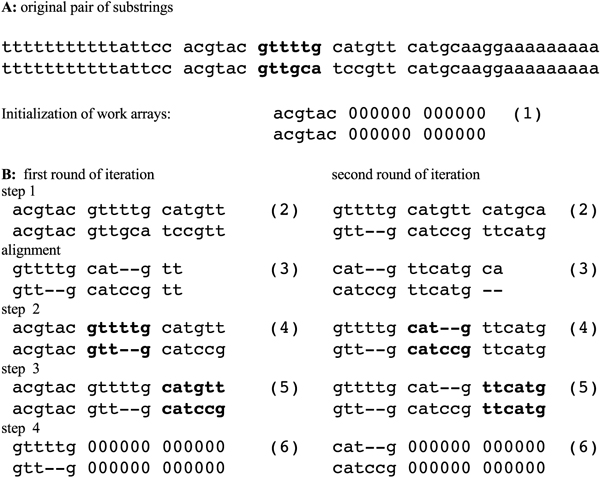
Match extension by window alignment for W = 6 and K = 2. Match extension by window alignment for window size W = 6 and maximum number of errors K = 2. A: We show the original pair of sub-sequences. Beginning from the left, the first window with 3 errors is printed in bold. Both neighbouring windows are separated by blanks. The work arrays (1) are initialized with the contents of the left hand side windows. B: We show the changes of the work arrays for the single steps of iterations described in Section Algorithm. Step 1: The central and right hand side blocks of (1) are overwritten by the next 12 original sequence characters yielding (2). An optimal alignment of these 12 sequence characters is given in (3). Step 2: The central blocks of (2) are overwritten by the first six characters of the alignment (3) and the right hand side blocks of (2) are overwritten by the next 6 original sequence characters yielding (4). Step 3: From the left to the right the first window of size 6 with 3 errors is printed in bold. Its starting position is T = 2W +1 and the existence of gaps in the central block requires step 4. Step 4: The central blocks of (5) are shifted to the start positions of the work arrays to set the initialization for the next round of iteration shown to the left of the first round. The third round of iteration ends in step 3 without gaps in the central and right hand side blocks of (5) and initiates match extension without gaps as described in the text.